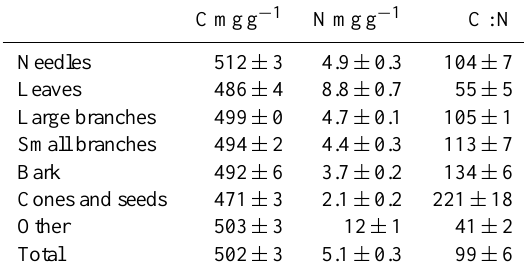
Table 2. Nitrogen and carbon contents and carbon-to-nitrogen- ratios in the annual litter fall, and in different litter fractions in Scots pine forest at Hyyti¨al¨a during 2006 to 2008. “Cones and seeds” rep- resents all the material distinguished as reproductive material, but it mostly consists of cones. Uncertainty is standard error of the annual